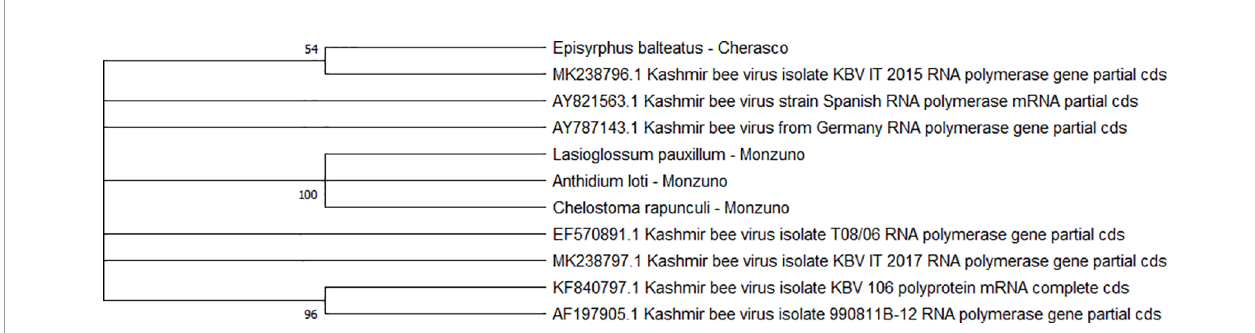
FIGURE 6 | Maximum likelihood nucleotide phylogeny of KBV RNA polymerase gene. This analysis involved 11 nucleotide sequences. There were a total of 421 positions in the fi nal dataset. Only those with bootstrap > 50% are reported. Species and sampling sites are reported for the sequences identi fi ed in this study. KBV, Kashmir bee